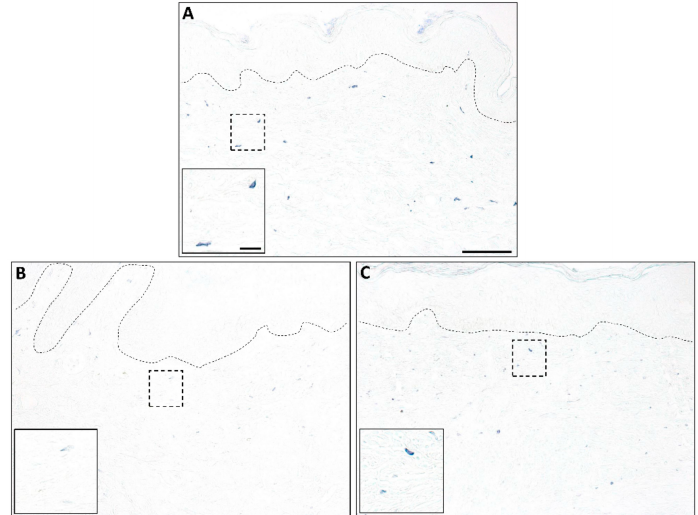
Figure 4. Mast cells in human wounds. Toluidine blue staining of human skin ( A ) and wounds at 4 weeks ( B ) or 8 weeks ( C ) post-injury shows changes in mast cells during healing. Mast cells with dense staining are present in unwounded skin, and an increase in mast cell numbers can be seen in 4- and 8-week wounds. Mast cells in 4-week wounds stain less intensely than those in 8-week wounds, suggesting an increase in mast cell maturity as the wounds heal. Insets show a high magnification view of the boxed area; dotted lines denote the epidermal–dermal junction. Scale bar = 100 µ m; Inset scale bar = 20 µ